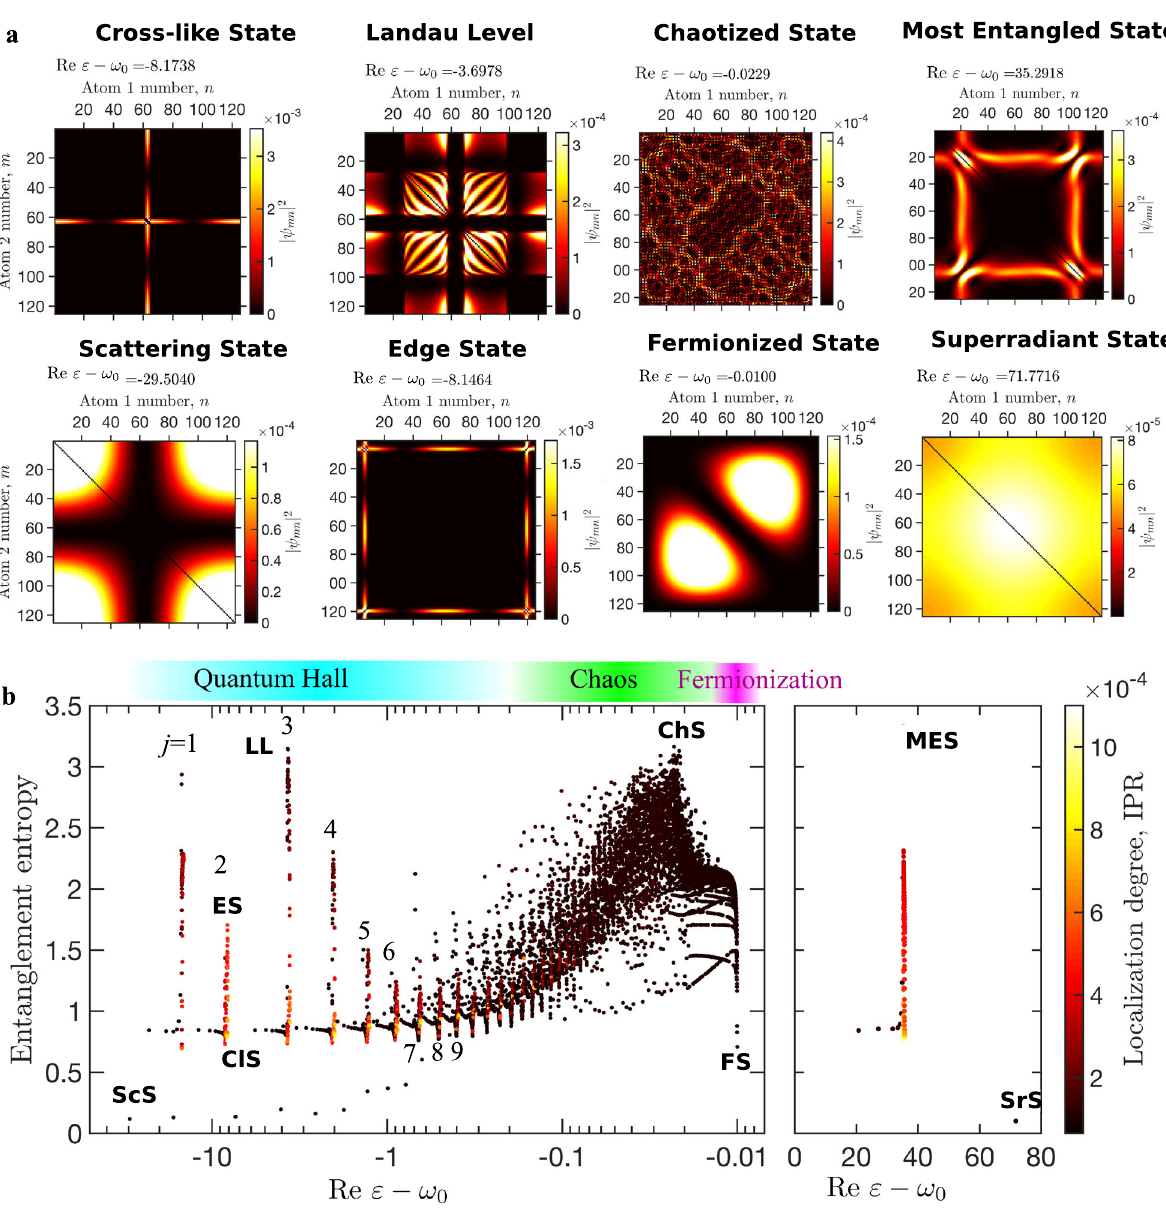
Fig. 4 Diversity of two-polariton states. a Characteristic wavefunctions for different types of two-polariton states, indicated in b by abbreviations. b Entanglement entropy depending on the state energy. Color shows the inverse participation ratio that characterizes the localization degree. Left and right panels correspond to the states with Re ε < ω 0 and Re ε > ω 0 , respectively. Standing wave numbers j are indicated near corresponding groups of states. Calculation has been performed for N = 125, ω 0 d / c = 0.02. Energy is measured in the units of Γ 0